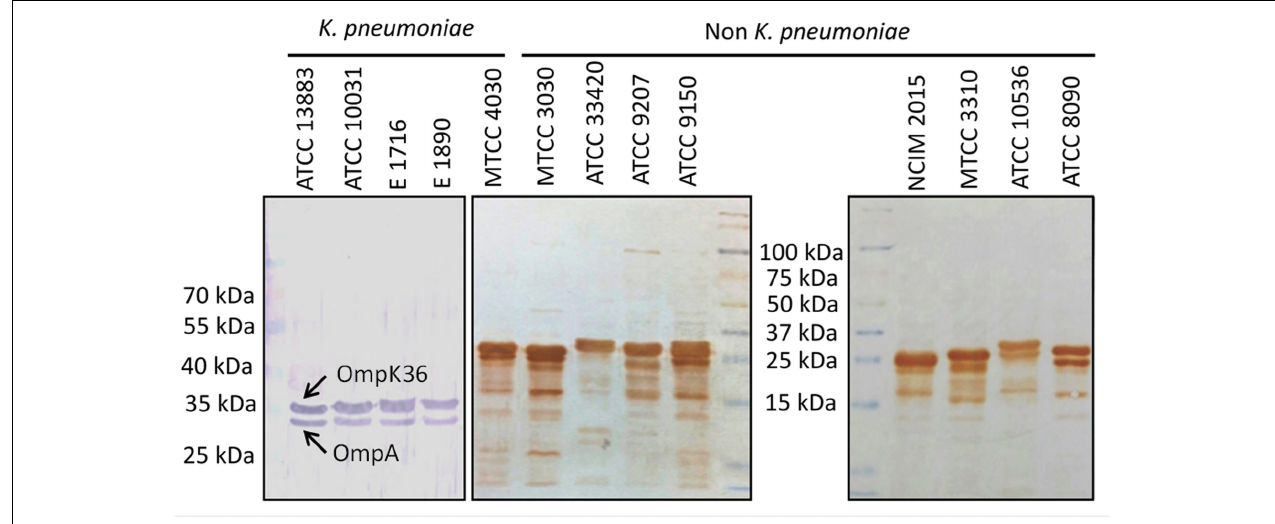
FIGURE 3 | Western blot analysis for testing reactivity of anti-r-AK36 antibodies with different Klebsiella pneumoniae and related Enterobacteriaceae members. Ant-r-AK36 serum reacted clearly with native OmpA and OmpK36 proteins of K. pneumoniae strains, while same serum cross-reacted with other members of Enterobacteriaceae at different regions.